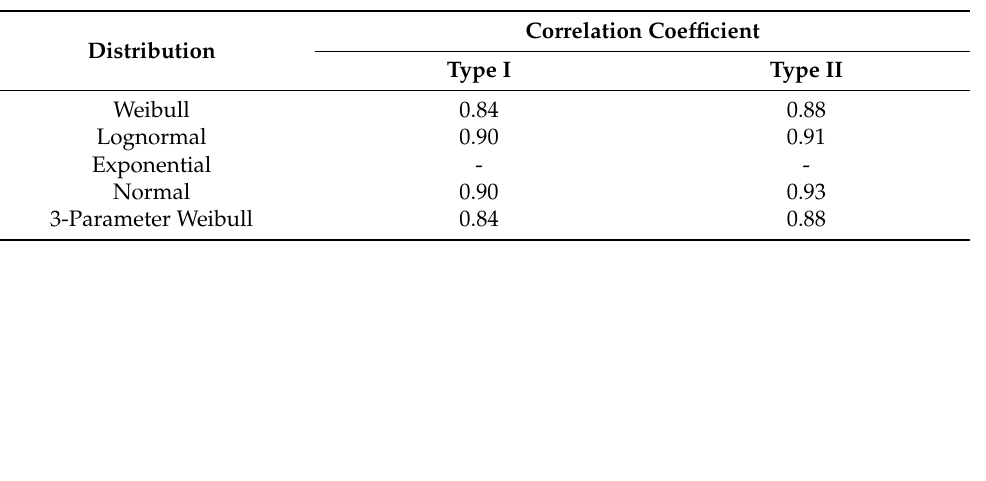
Table 2. Goodness-of-fit for milling